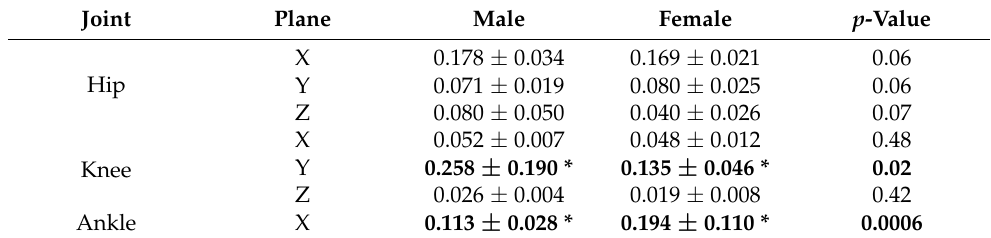
Table 2. Stiffness values of lower extremity joints between sexes (Mean ±